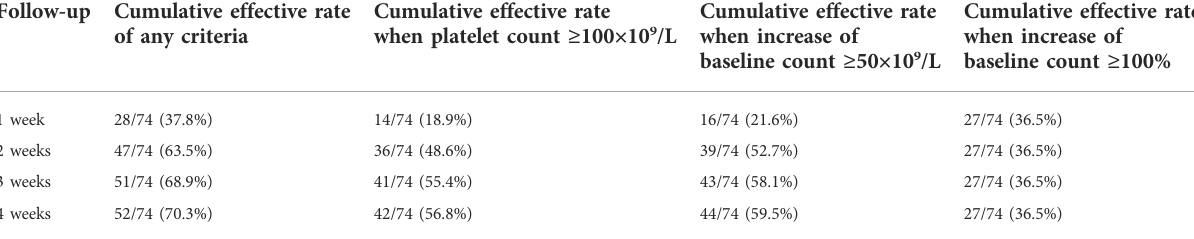
TABLE 2 Cumulative effective rate. Follow-up Cumulative effective rate of any